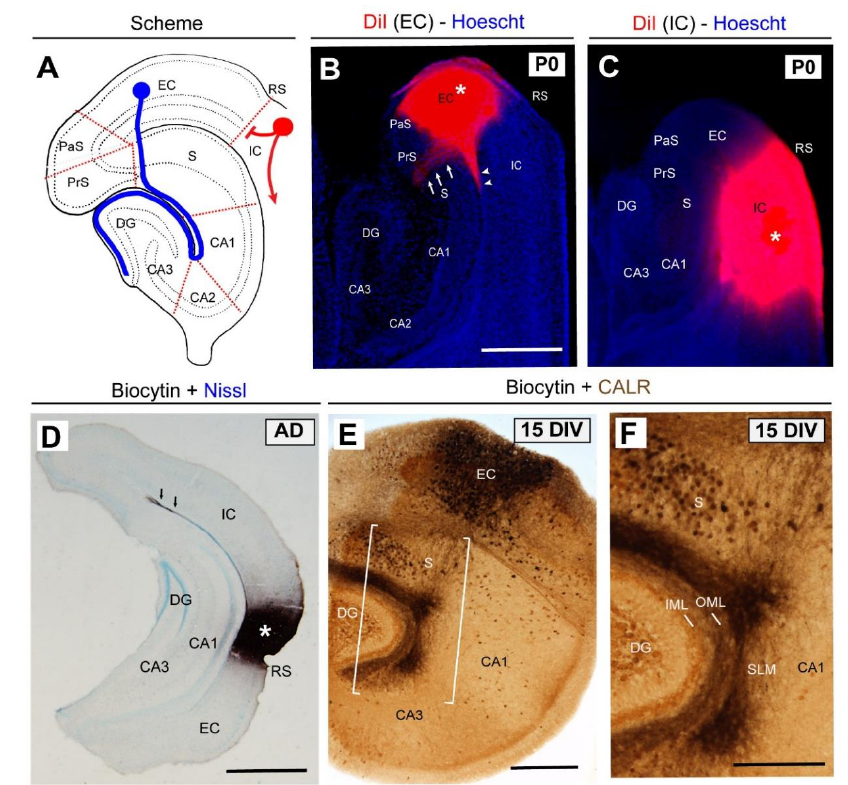
Figure 2. Lamina-specific innervation of the entorhino-hippocampal (EH) pathway. ( A ) Scheme of the hippocampal formation illustrating the EH (blue) and corticofugal (red) connections. ( B ) Pattern of EH innervation after DiI injection in the entorhinal cortex (asterisk) at P0. Note that entorhinal axons cross the subiculum (arrows) to reach the hippocampus proper. In parallel, entorhinal axons are also able to reach the CA1 of the hippocampus proper through the alveolar pathway (arrowheads). ( C ) In contrast, when DiI is injected in the isocortical region, no labeled axons are detected in the hippocampus. ( D ) Photomicrograph illustrating the lack of staining in the hippocampus when byocitin is injected in the perirhinal cortex (asterisk) in vivo in an adult animal. ( E ) Pattern of EH regeneration in organotypic slices after 15 DIV. ( F ) High-magnification of the boxed area in (E). Abbreviations as in Figure 1 and EC = entorhinal cortex; CALR = calretinin immunostaining; DIV = days in vitro; IC = isocortex, and RS = rhinal sulcus. Scale bars: B = 500 μm pertains to (C); D = 500 μm; E = 250 μm and F = 100 μm. In addition, axons forming the second main afferent connection of the hippocampus proper, the commissural/associational pathway, avoid the SLM/OML in vivo [13–15,27] as well as in vitro [23,25,26]; they are restricted to the stratum radiatum of the hippocampus proper and the innermost portion of the molecular layer (IML) of the dentate gyrus [8]. Only after lesion of the entorhinal fibers are the commissural/associational axons able to reinnervate the SLM/OML [25]. With respect to mossy fibers, postnatal and adult newborn granule cells extend their axons, forming synaptic contacts on hilar mossy cells and on proximal dendrites of the CA3 pyramidal cells in the stratum lucidum [8,12] .